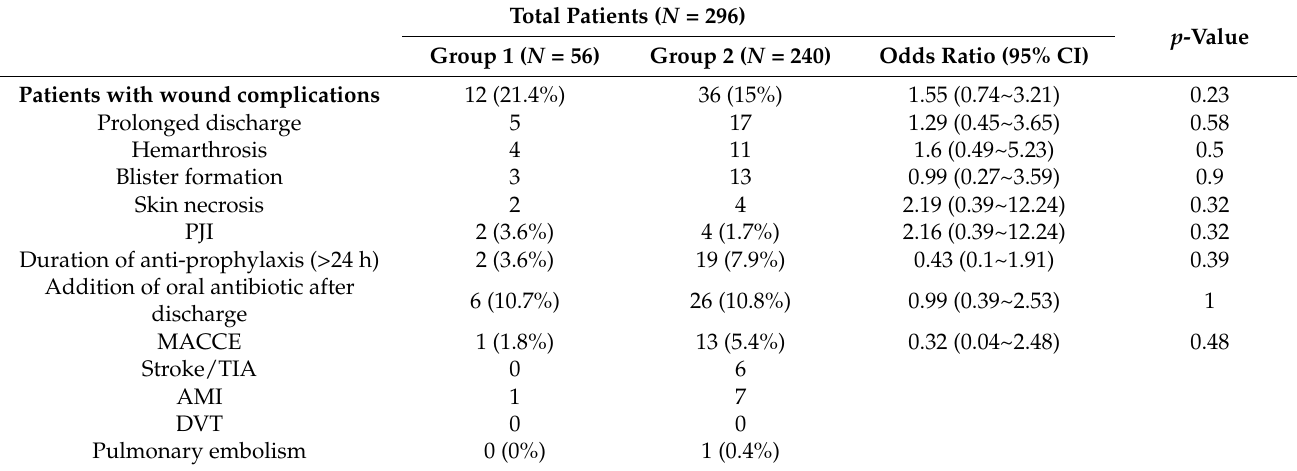
Table 3. Complications and antibiotic use between the two groups of